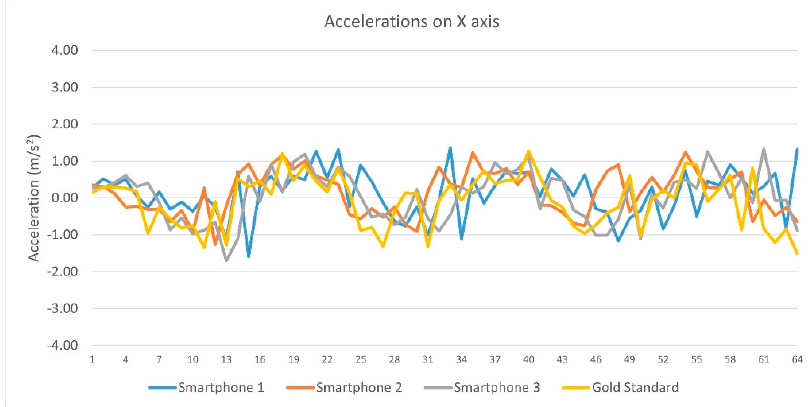
Figure 6. Pearson r correlations from each device linear acceleration’s data on the X axis. Concerning linear acceleration data from each device on the Y axis, Pearson’s correlation coefficient (r) showed significant correlations between (a) Smartphone 1 and Vicon system (Pearson r = − 0.415, sig = 0.000), (b) Smartphone 2 and Vicon system (Pearson r = − 0.354, sig = 0.002) and (c) Smartphones 3 and Vicon system (Pearson r = 0.292, sig = 0.001). Pearson r correlation from each device linear acceleration’s data on the Y axis are displayed in Table 4 and Figure 7. Table 4. Pearson r correlations from each device linear acceleration’s data on the Y axis. Y Axis Smartphone 1 Y Axis Smartphone 2 Y Axis Smartphone 3 Y Axis Vicon Y axis smartphone 1